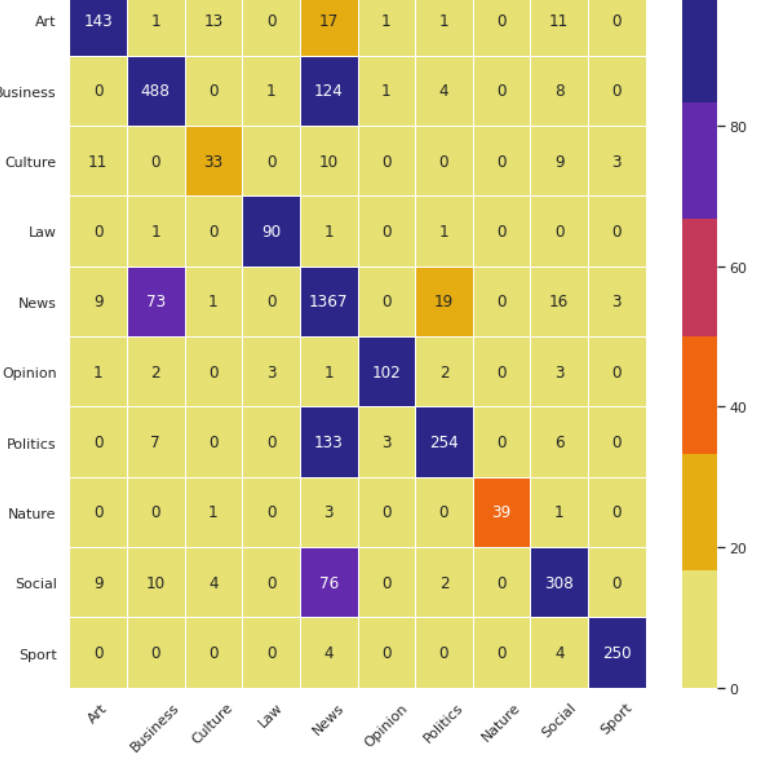
Figure 8. The confusion matrix result by SVM topic detection using TF-IDF with no application of